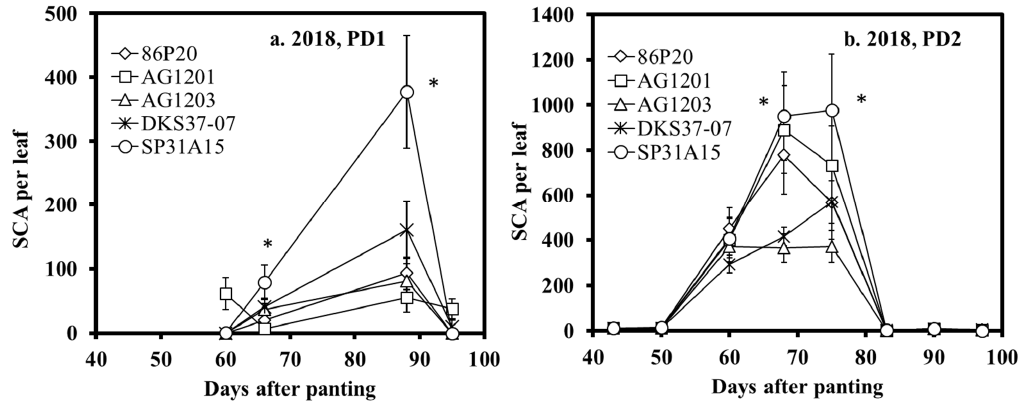
Figure 3. Average sugarcane aphid (SCA) population per leaf in each hybrid observed for the PD1 ( a ) and PD2 ( b ) grain sorghum in 2018. * Indicates the significant differences ( p < 0.05) in SCA per leaf among hybrids.